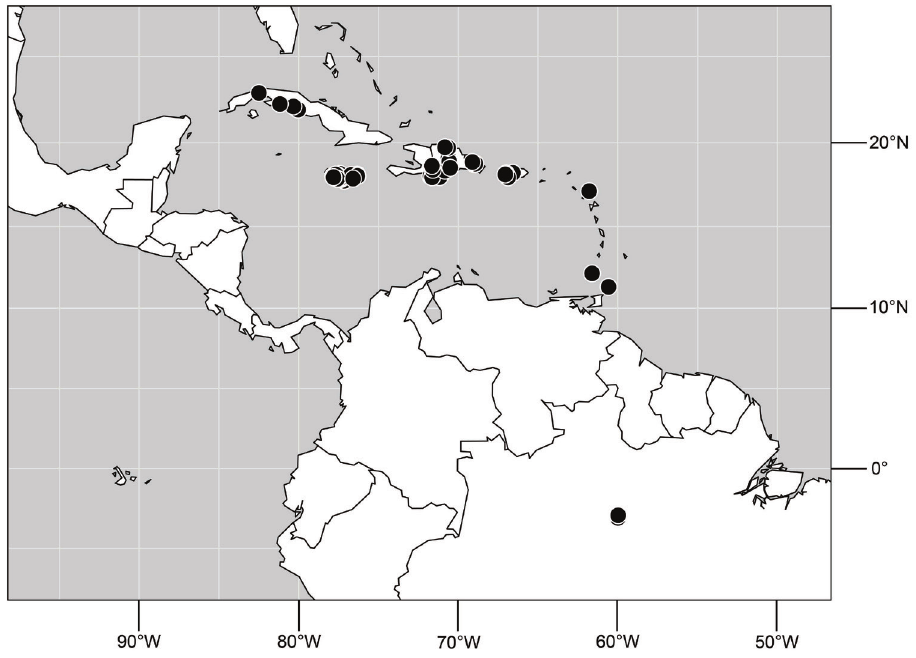
Figure 119. Distribution of Hydrochasma peniculum sp.